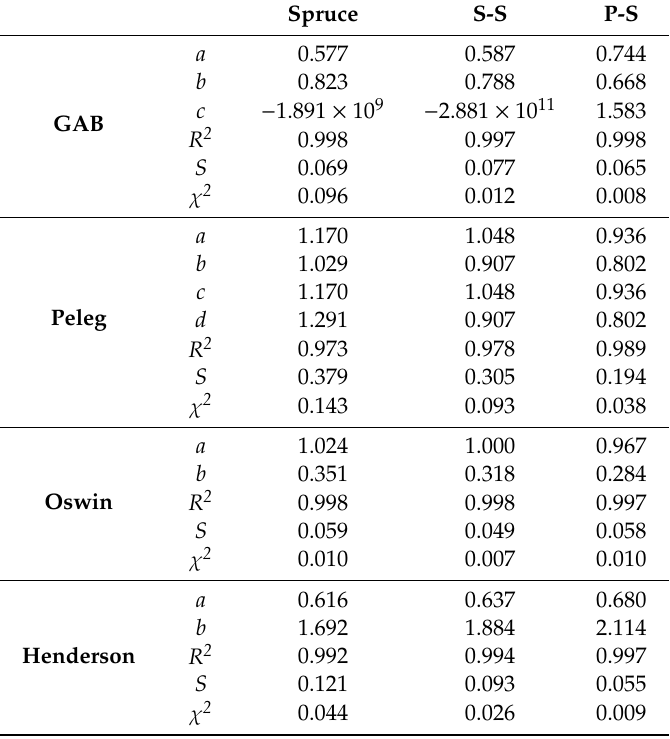
Table 3. Modeling of moisture sorption behavior of mixed biomass pellets. S-S: spruce–switchgrass. P-S: